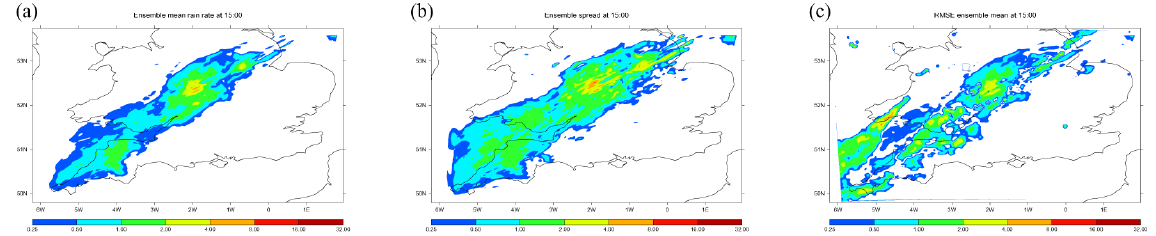
Fig. 16. Rain rate diagnostics for the IC+BC+RPfix ensemble (mmh − 1 ). (a) ensemble mean, (b) ensemble spread and (c) innovation magnitude of the ensemble mean, all at 15:00UTC 20 September